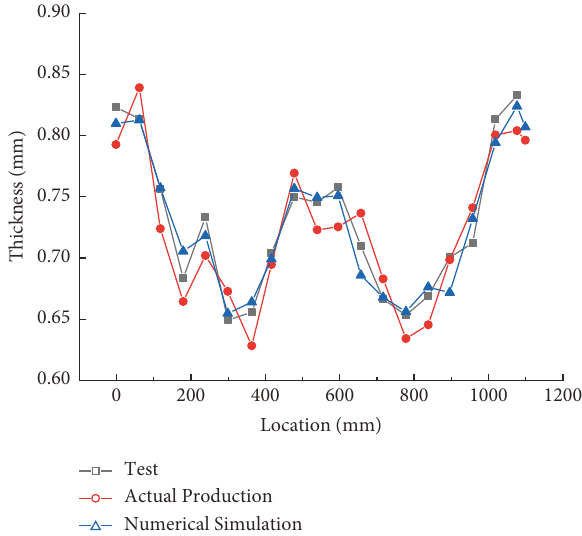
Figure 7: Thickness comparison of test, simulation, and actual production results.